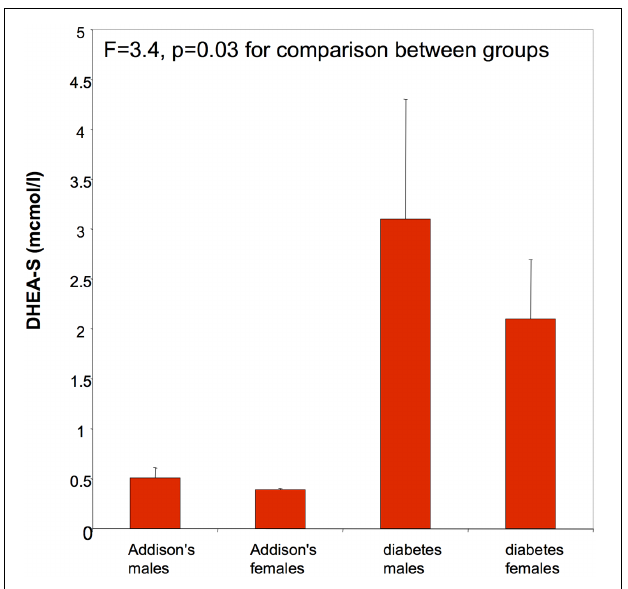
FIGURE 2 | Testosterone levels were normal in men (normal range mean: 10.0–35.0 nmol/l) and women (normal range mean: 0–2.4 nmol/l) in both Addison’s patients and type 2 diabetes patients.